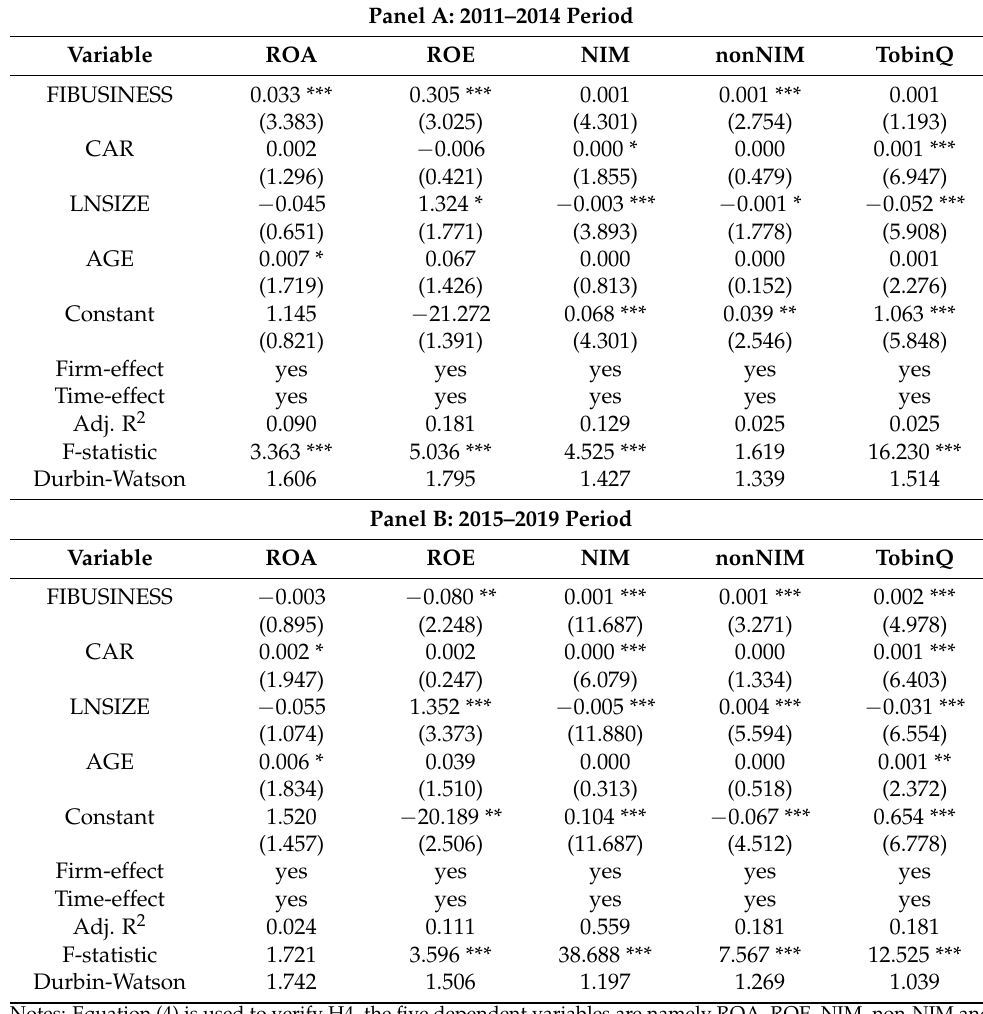
Table 5. The correlation between financial innovation and bank